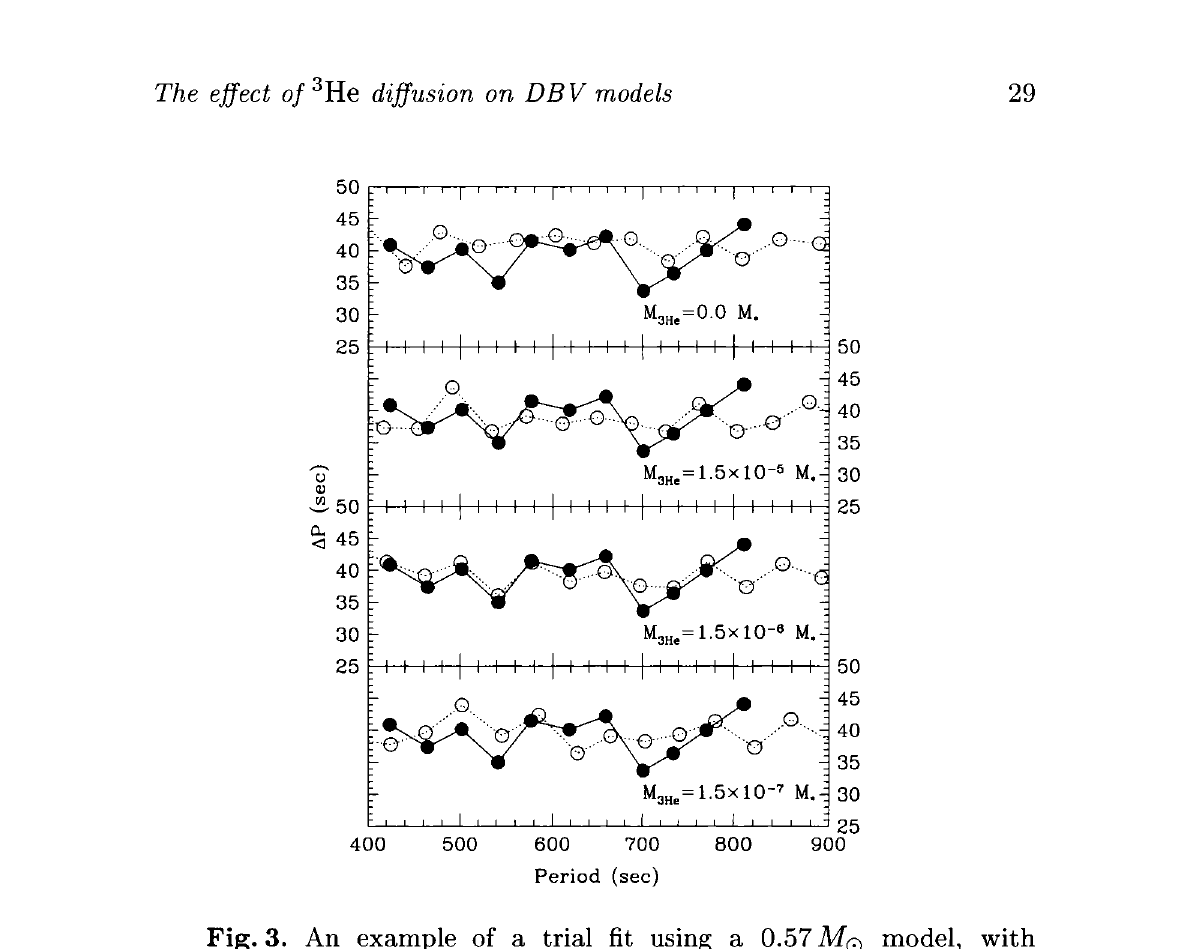
Fig. 3. An example of a trial fit using a 0.57 M© model, with M4n e /M± = 1.5 • 1 0 -2 and as shown in each panel. We see